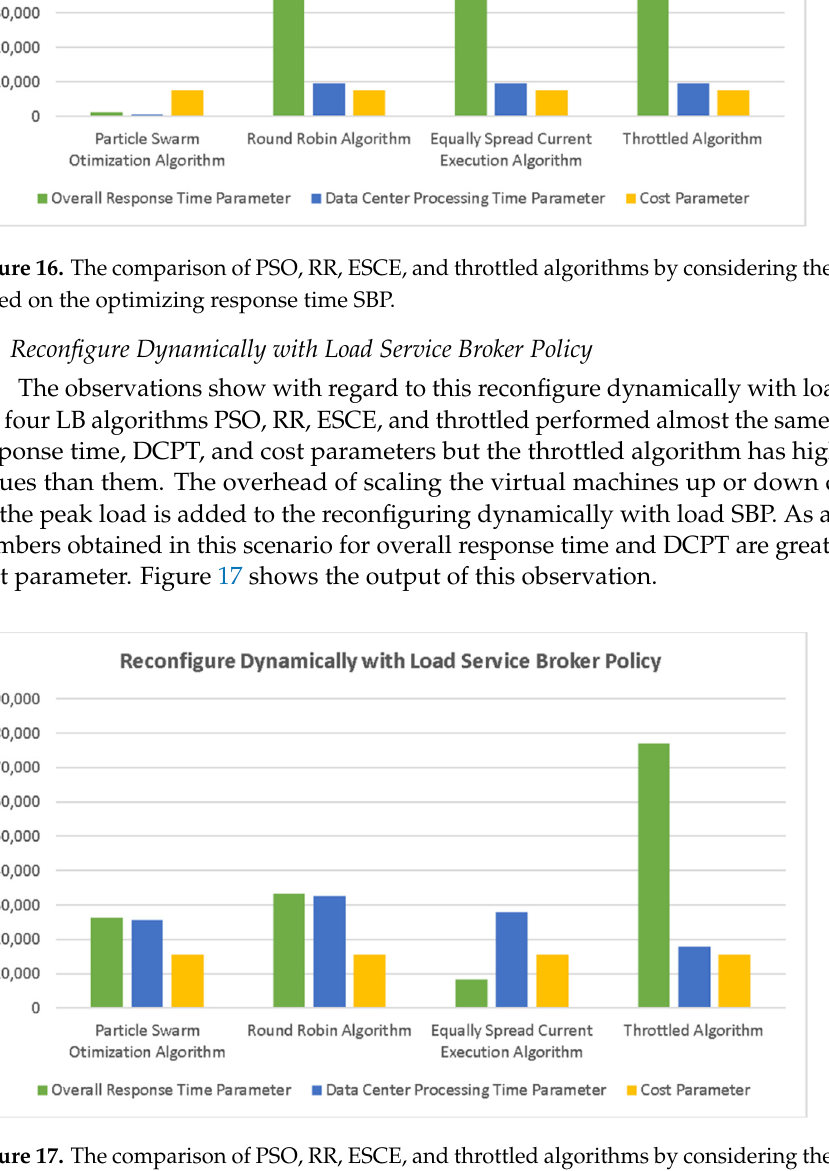
Figure 15. The comparison of PSO and RR, ESCE, and throttled algorithms by considering the pa- rameters based on CDC SBP.